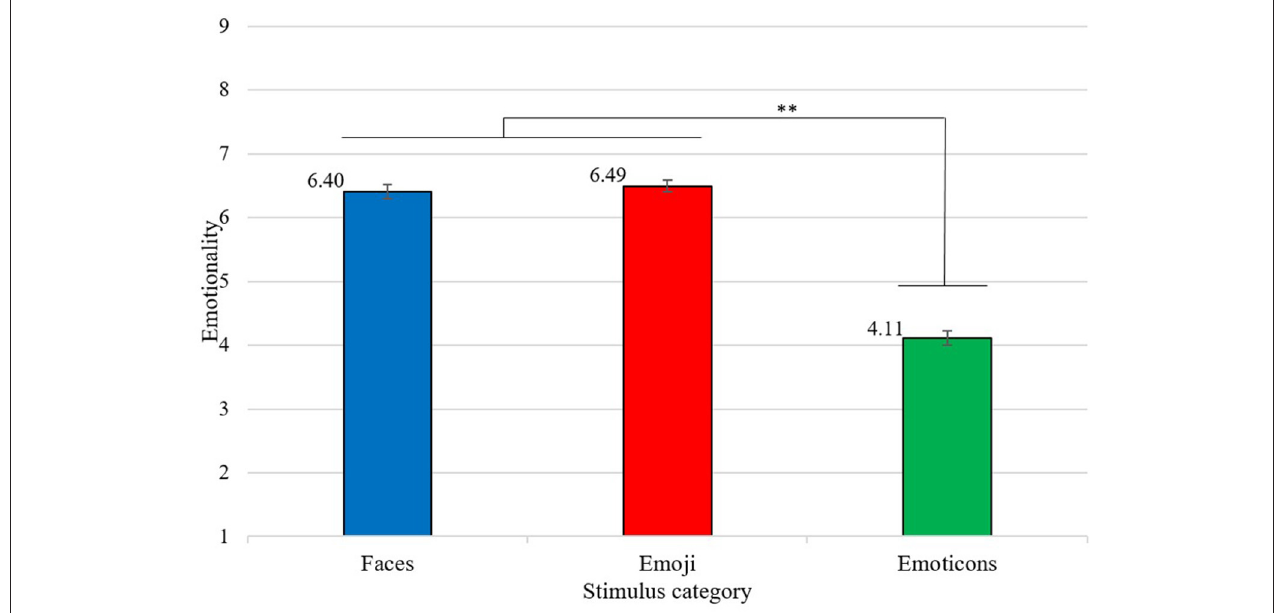
FIGURE 2 | Mean emotionality scores for each stimulus category, from 1 = “not at all,” to 9 = “totally.” Error bars depicted in standard errors (SE) . ** p < 0.01.